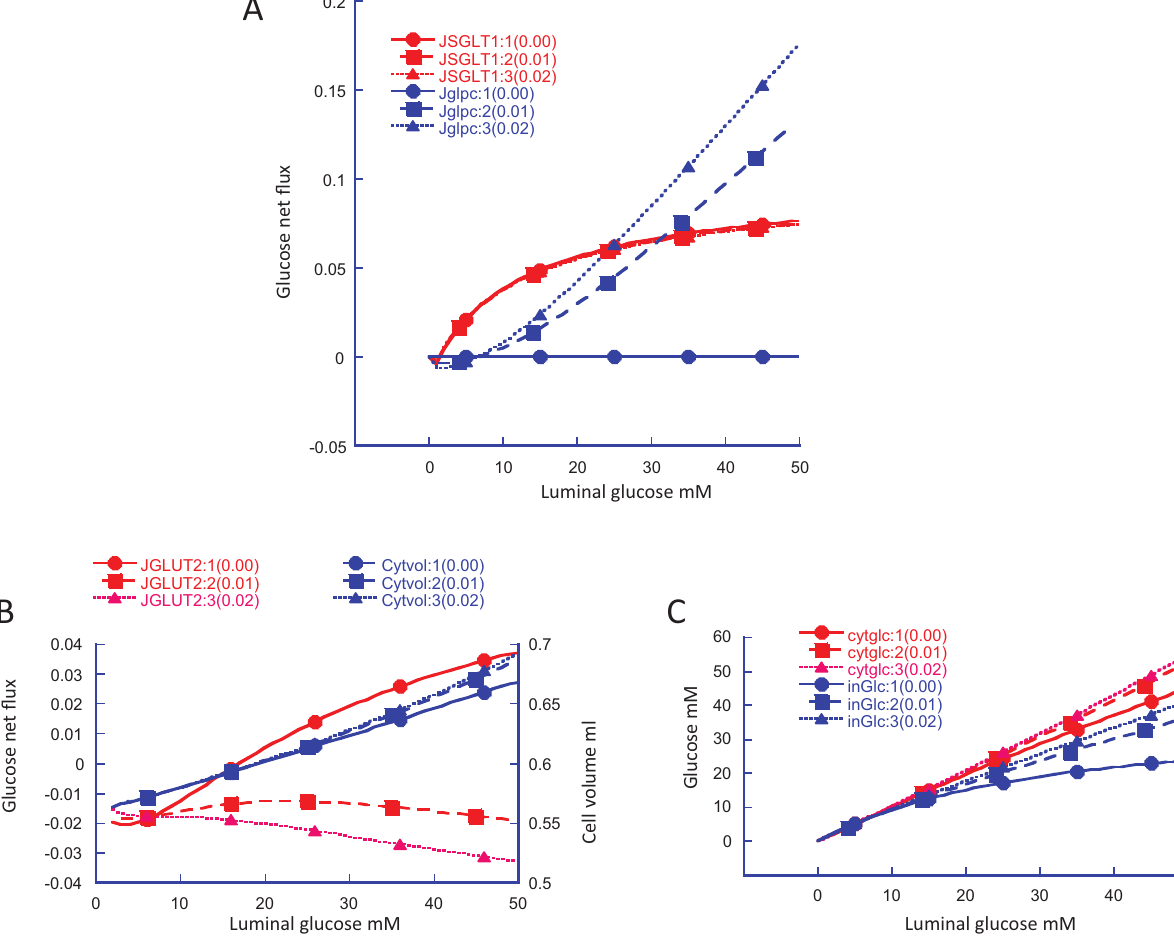
Luminal glucose Figure 3. Simulation of effects of varying paracellular glucose permeability on intestinal glucose fluxes and accumulation. The effects of varying paracellular glucose permeability P glc from 0 to 0.02 cm s -1 are shown in Figure 3A increasing P glc on paracellular glucose flux (Blue). As P glc is increased from zero the point of equality of paracellular glucose flux Jglpc with glucose flux via SGLT1 decreases from infinity at P glc = 0 to around 20–30 mM luminal glucose when P glc = 0.01–0.02 cm s -1 . Increases P glc raises interstitial glucose concentrations 3C (blue) and in parallel, cysosolic concentrations Figure 3C (red). The reduction in glucose gradient across the basolateral membrane with raised P glc reduces and then reverses glucose flux via GLUT2 (Figure 3B).